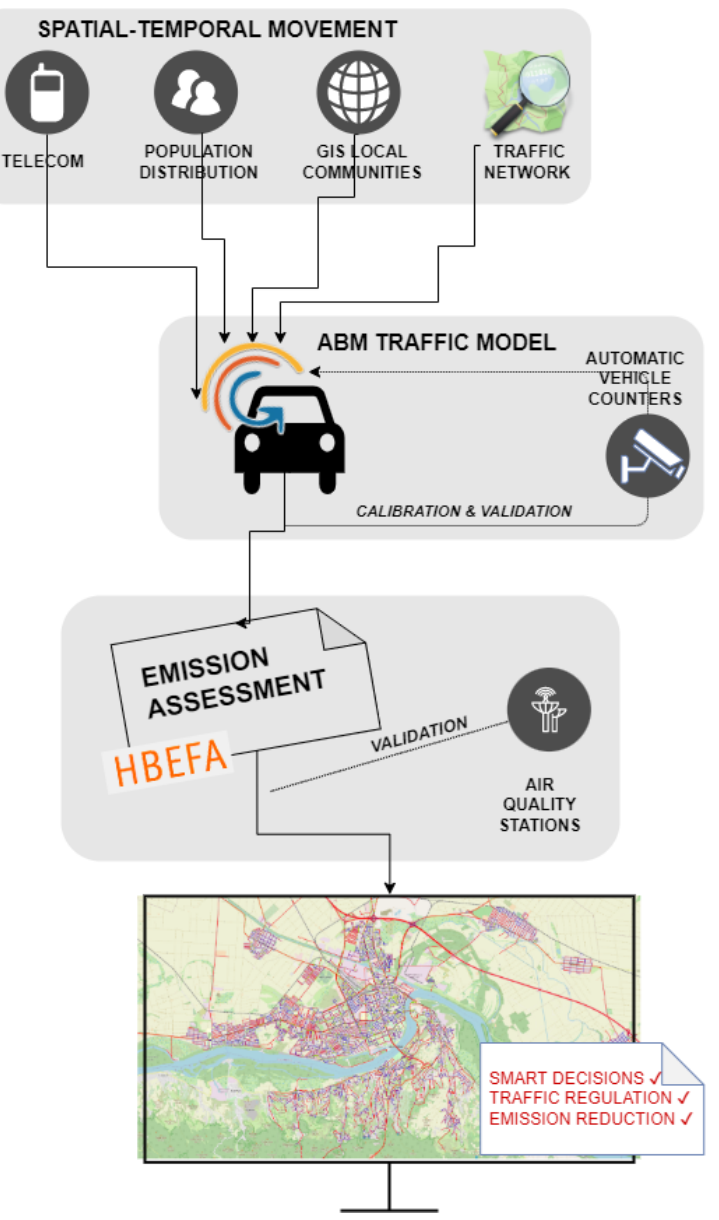
Figure 1. The scheme of the proposed